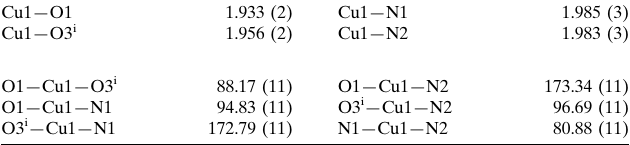
Selected geometric parameters (A˚ , (cid:1)